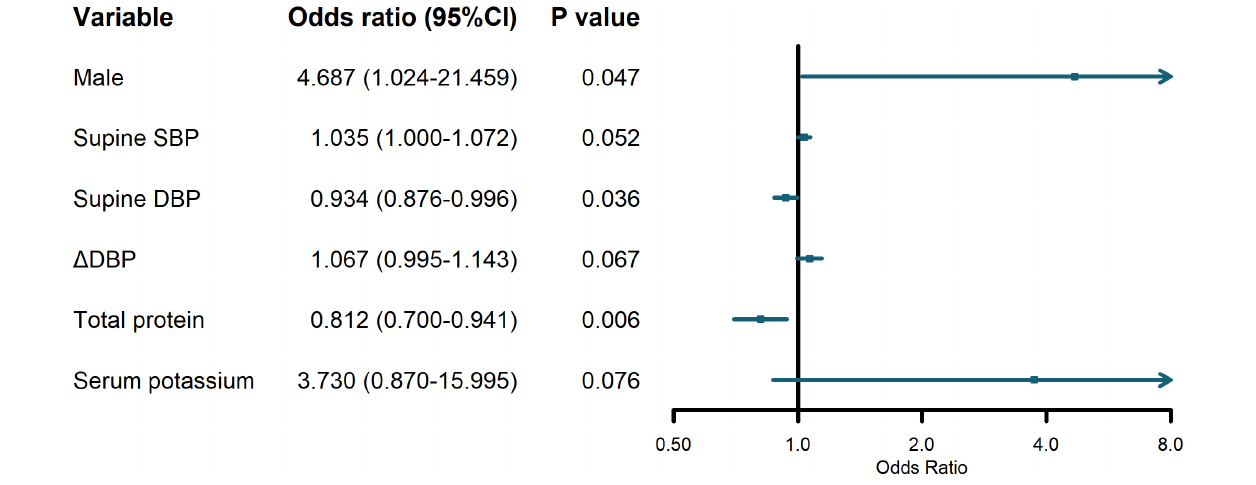
FIGURE 2 | Odds ratios (OR) and 95% confidence interval (CI) of predictor variables on increasing orthostatic change of systolic blood pressure ( (cid:49) SBP)